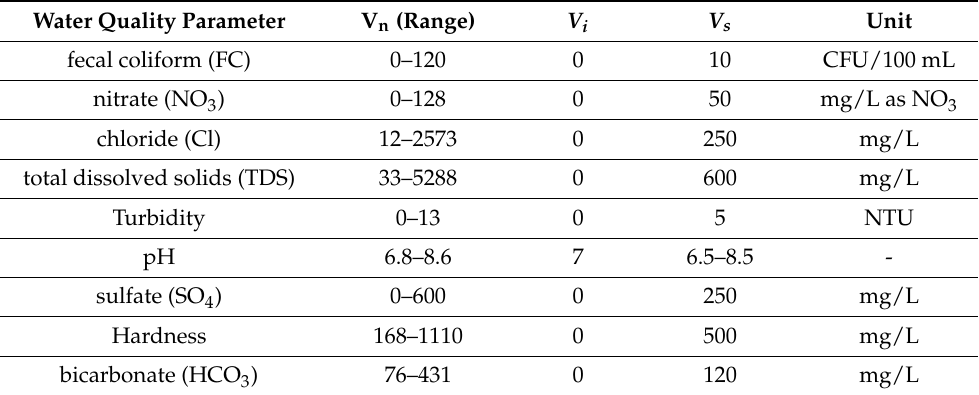
Table 2. V n , V i , and V s values of water quality parameters [53,55,56].